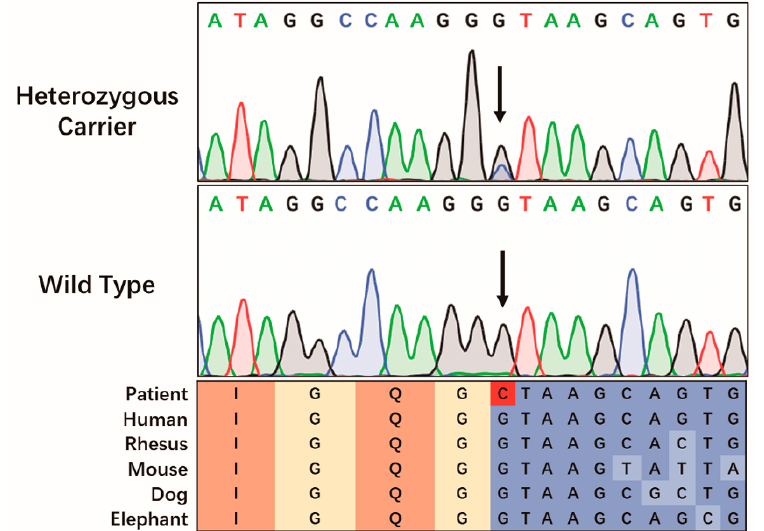
Figure 2. The Sanger sequencing results of the MFS pedigree. Arrows indicate the position of the mutation. Colored blocks show the evolutionary conservation around the mutation across multiple species.